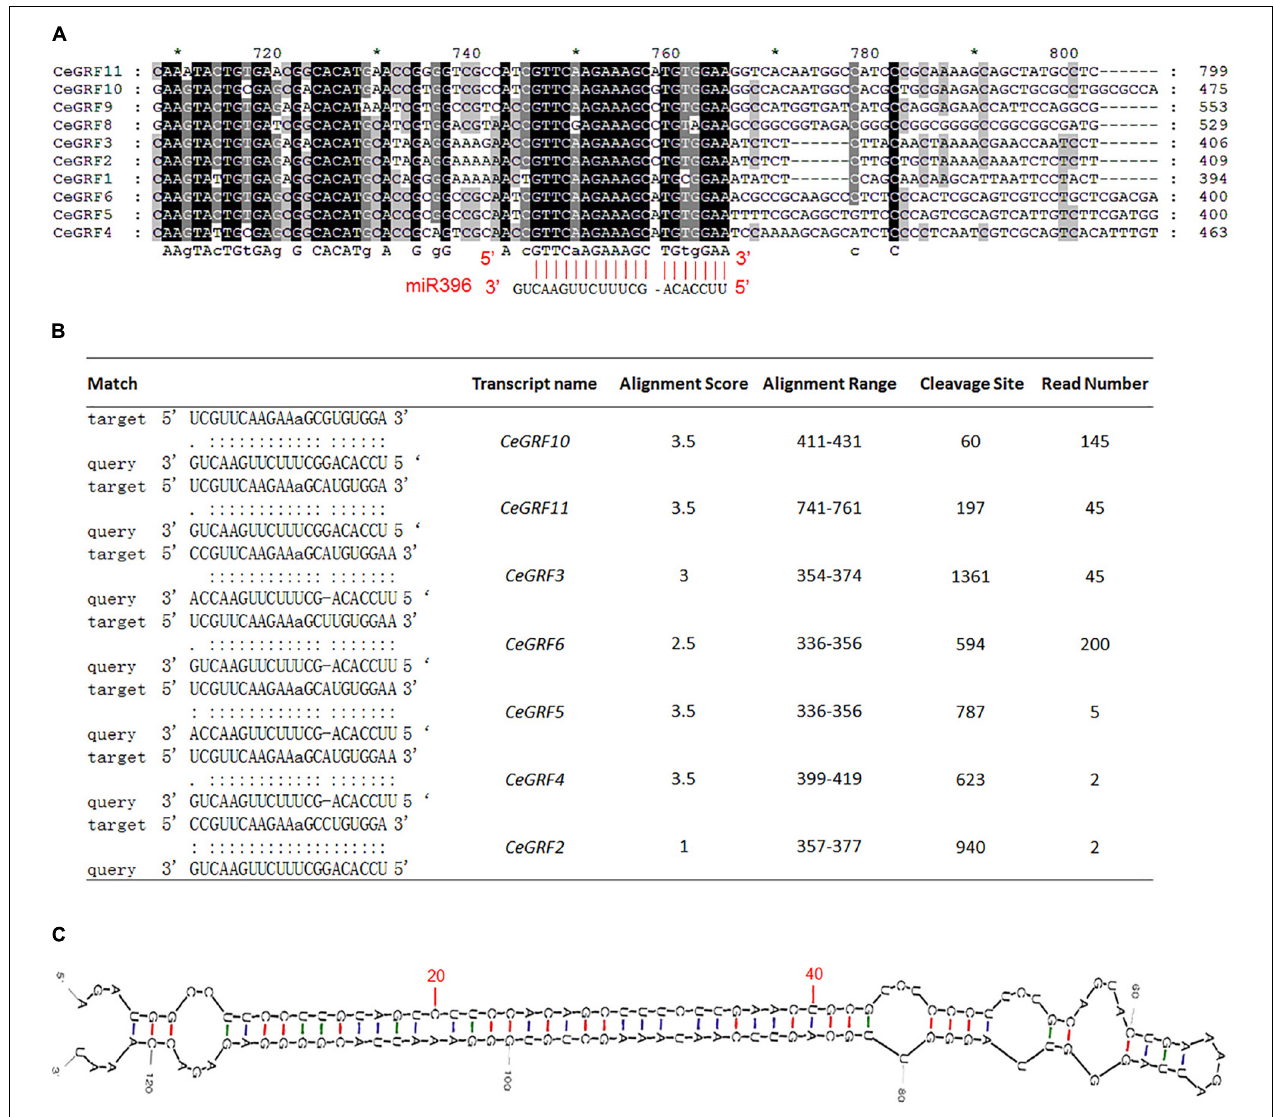
FIGURE 4 | Cymbidium ensifolium Growth-Regulating Factors are Targeted by Ce- miR396. (A) Complementary matching between miR396 and CeGRFs . (B) Identification of the targeted GRF genes of miR396 by degradome sequencing, read number indicated normalized reads that matched the different positions of the targeted genes. Only the cleavage sites with P value < 0.05 were counted. (C) Secondary structure of pre- Ce -miR396 of Cymbidium ensifolium . The mature sequences that match the precursor detected by small RNA-Seq are displayed in red.